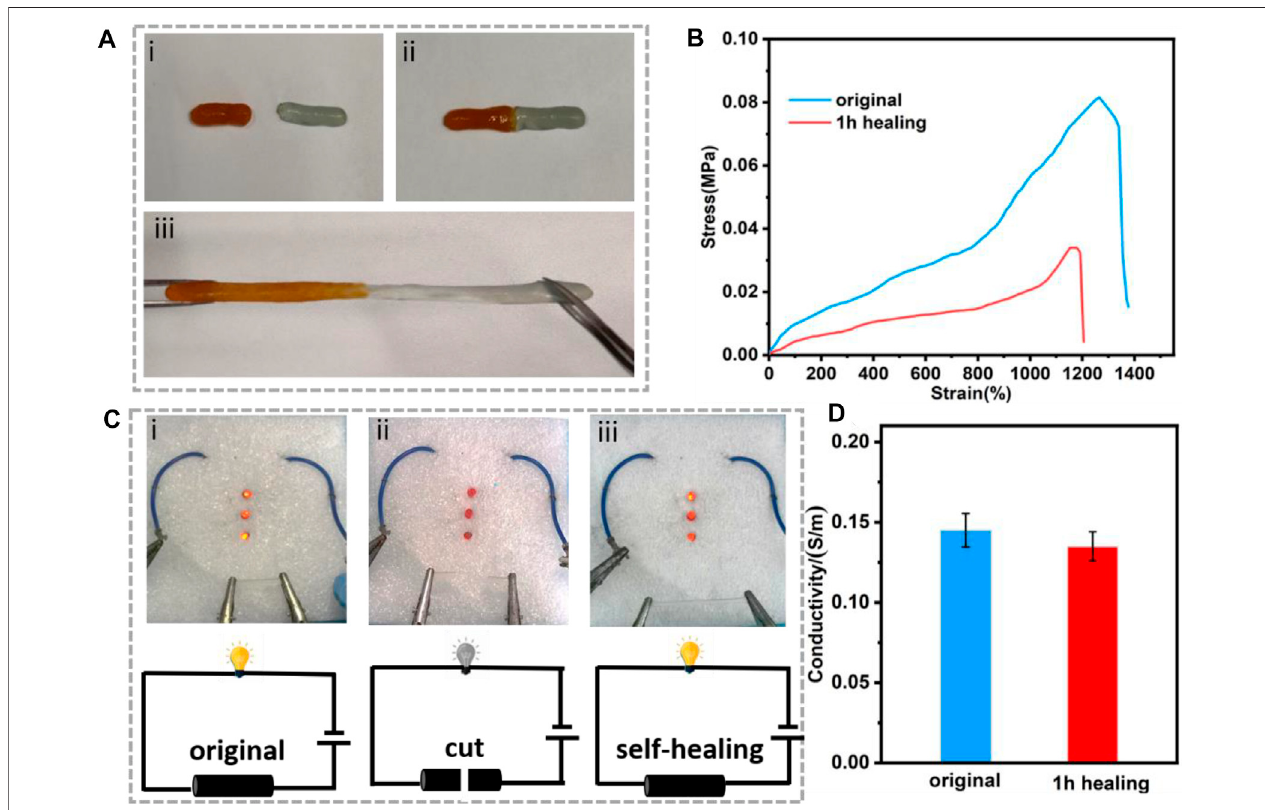
FIGURE 4 | (A) The self-healing behavior of the ADN 1.5 hydrogel: (i) original hydrogel, (ii) completely broken hydrogel, (iii) stretched hydrogel after self-healing. (B) Tensile strain vs. stress curves of the hydrogel after self-healing. (C) A circuit consisting of the hydrogel in series with red LED bulbs: (i) original hydrogel, (ii) completely broken hydrogel, (ii) self-healed hydrogel, and the corresponding schematic diagrams of the circuit. (D) The conductivity of the ADN 1.5 hydrogel after 1 h healing.